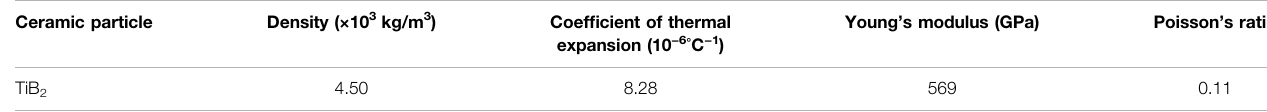
TABLE 2 | Properties of ceramic particles TiB 2 . Ceramic particle